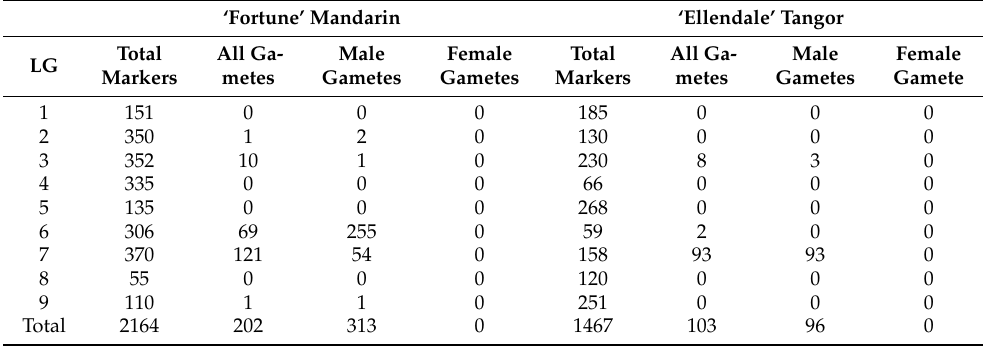
Table 3. Number of markers with significant segregation distortions for all efficient male and fe- male gametes of ‘Fortune’ mandarin and ‘Ellendale’ tangor.